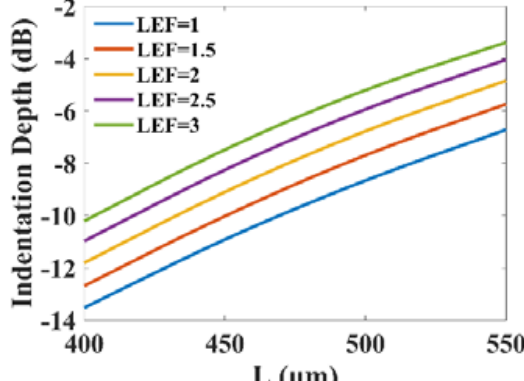
Figure 6. The indentation depth dependence on α LEF for a few L with P bias = 12 mW, κ = 100/cm and R f = R r = 0.2 .